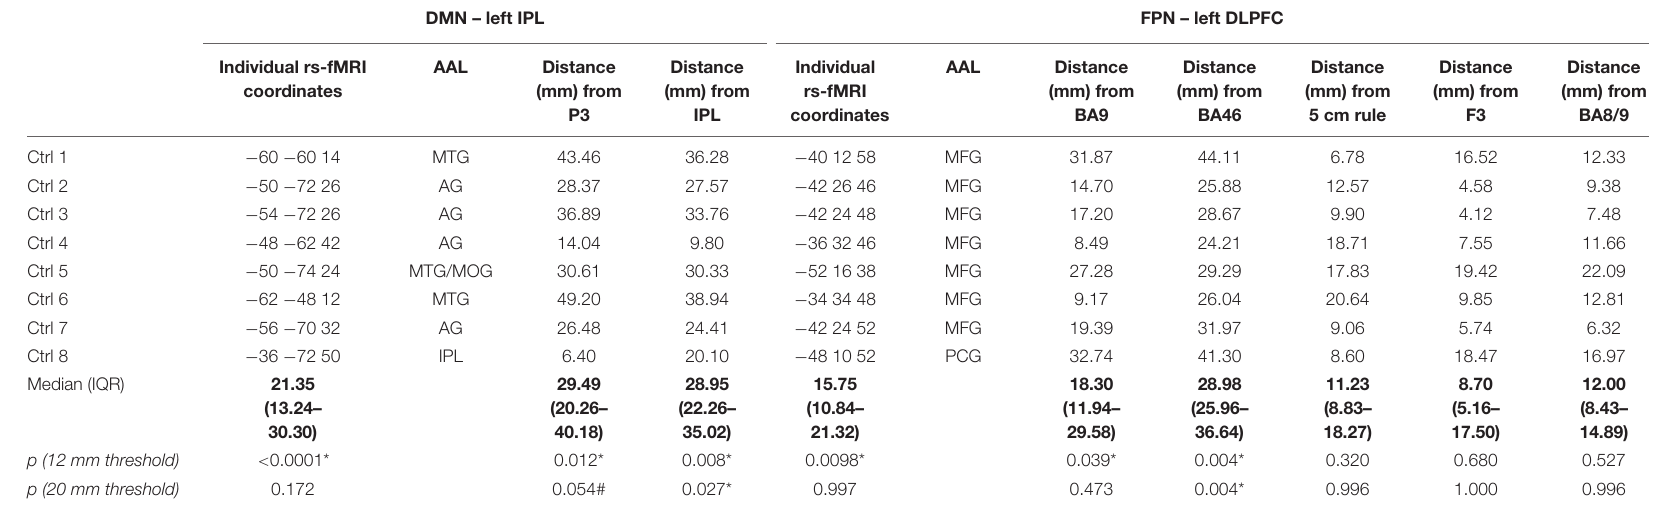
The corresponding anatomical region is provided based on the Anatomical atlas label (AAL) and the average distance between individual coordinates and group-level coordinates is provided. Results of one-sample Wilcoxon tests (p-values) assessing the null hypothesis that the distance between individual and group-level coordinates is below 12 mm and 20 mm are reported (*significant difference; #trend toward significance). DMN, default mode network; FPN, fronto-parietal network; BA8/9, Broadmann areas 8 and 9; BA9, Broadmann area 9; BA46, Broadmann area 46; IPL, inferior parietal lobule; DLPFC, dorsolateral prefrontal cortex; AG, angular gyrus; IFG, inferior frontal gyrus; MFG, middle frontal gyrus; MTG, middle temporal gyrus; MOG, middle occipital gyrus; PCG, precentral gyrus; IQR, interquartile range. Bold numbers depict median and IQR